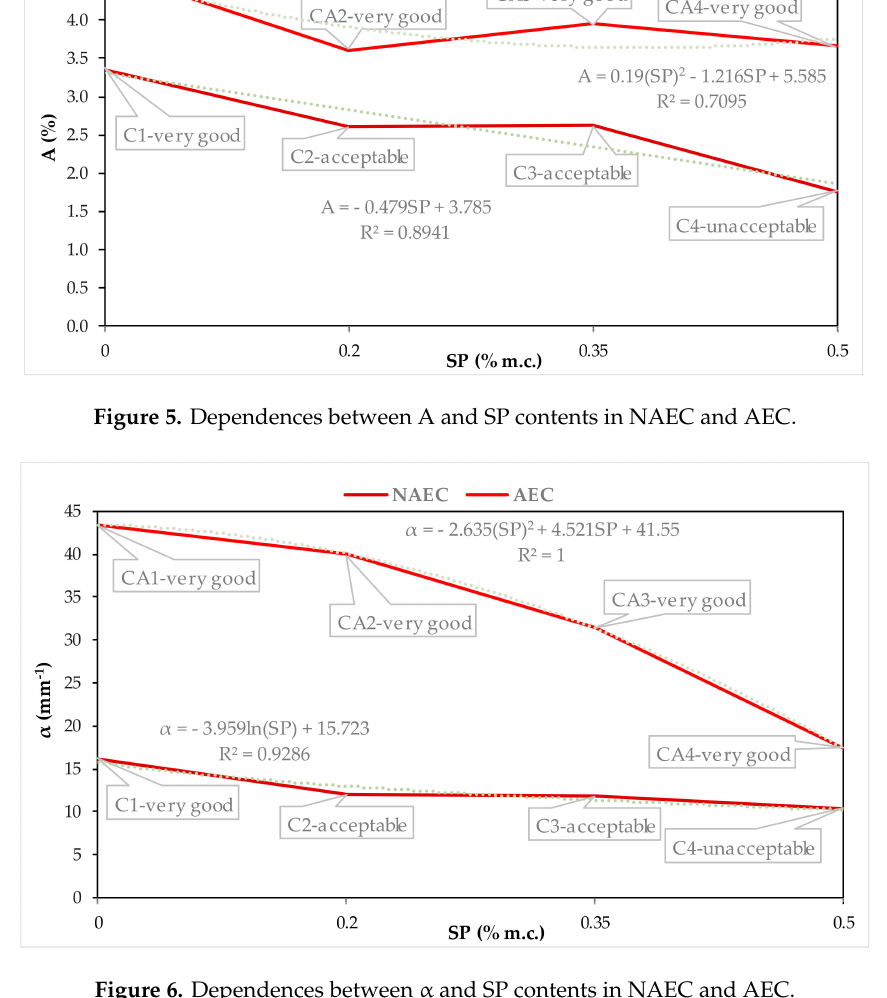
Figure 6. Dependences between α and SP contents in NAEC and AEC.